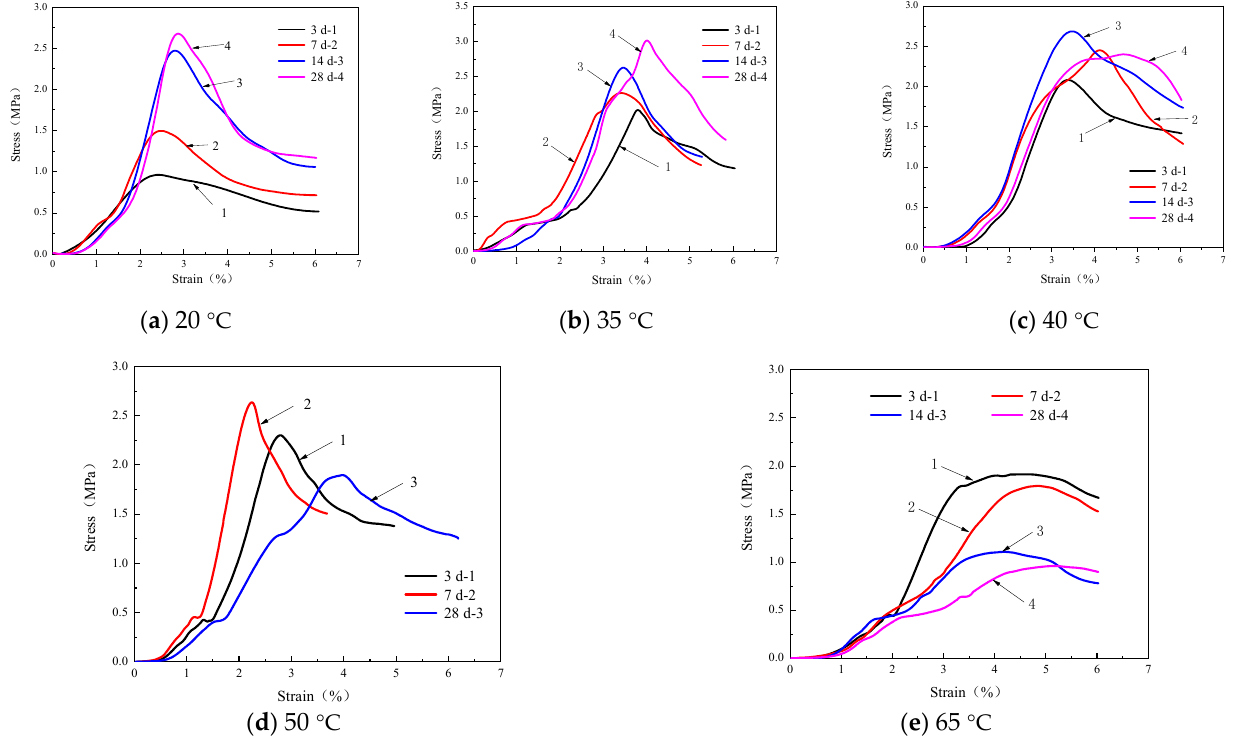
Figure 16. Stress-strain curves of CPB at different times.